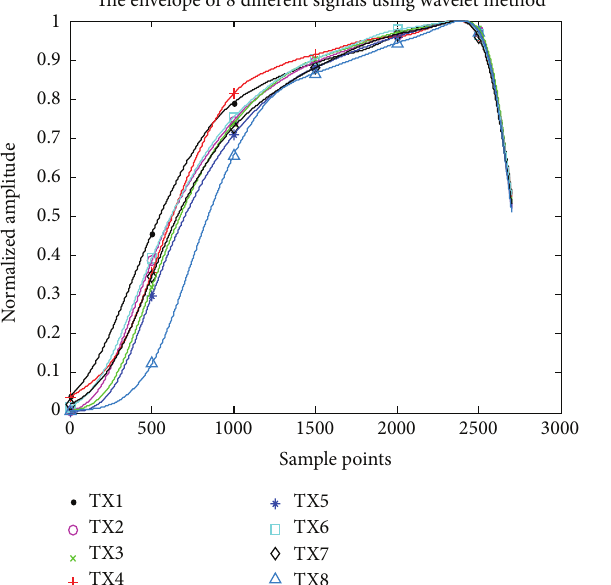
Figure 6: The envelope extraction of 8 different wireless transmit- ters using complex analytical wavelet transform.